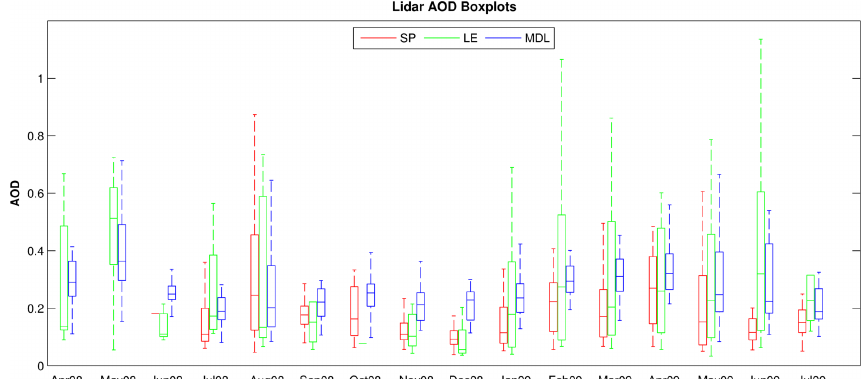
Figure 8. Temporal variability in simulated AOD compared with observations at the LST site. The box plots of monthly values are shown. AOD from the sun photometer (SP) and integrated from the vertical extinction profiles (LE) are shown. MDL denotes modeled values. “Lidar” denotes the LST site. In each box-and-whisker panel, the middle line denotes the median value, while the edges of the box represent 25th and 75th percentile values, respectively. The whiskers denote the maximum and minimum